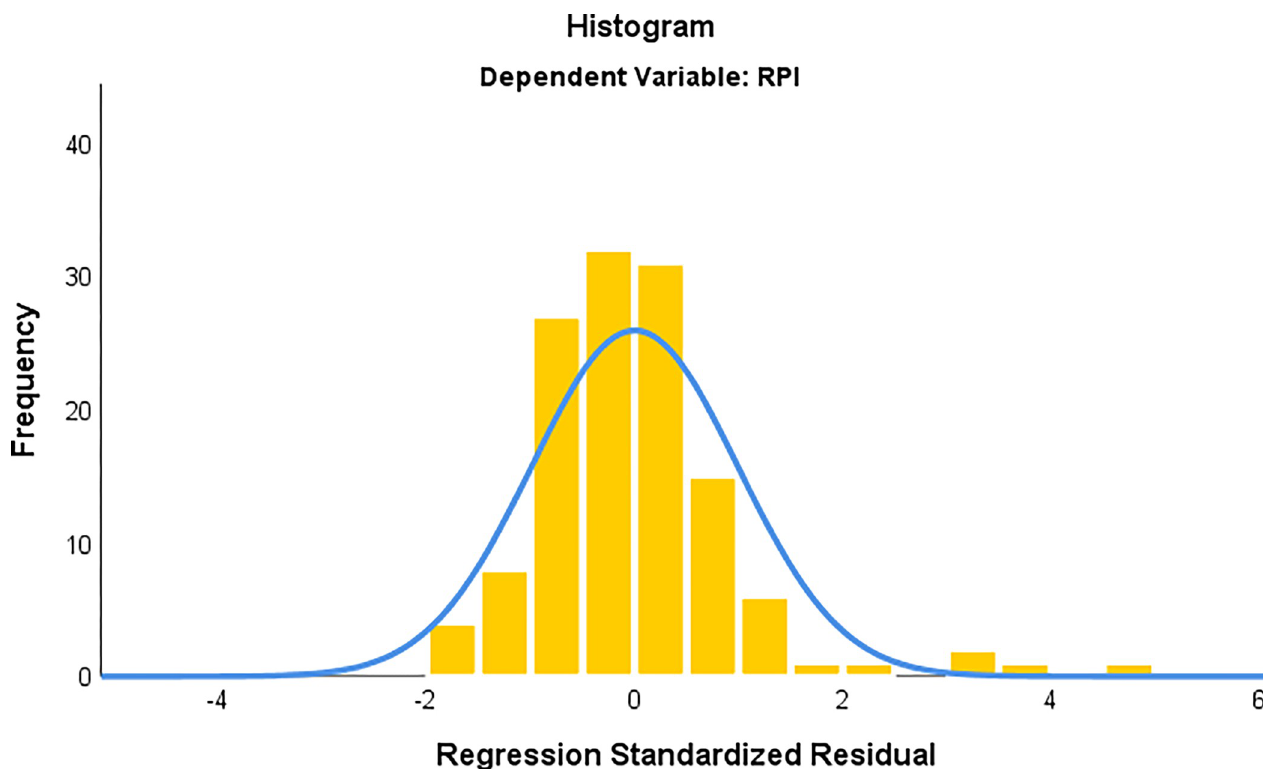
Fig 7. Distribution diagram of principal component regression prediction